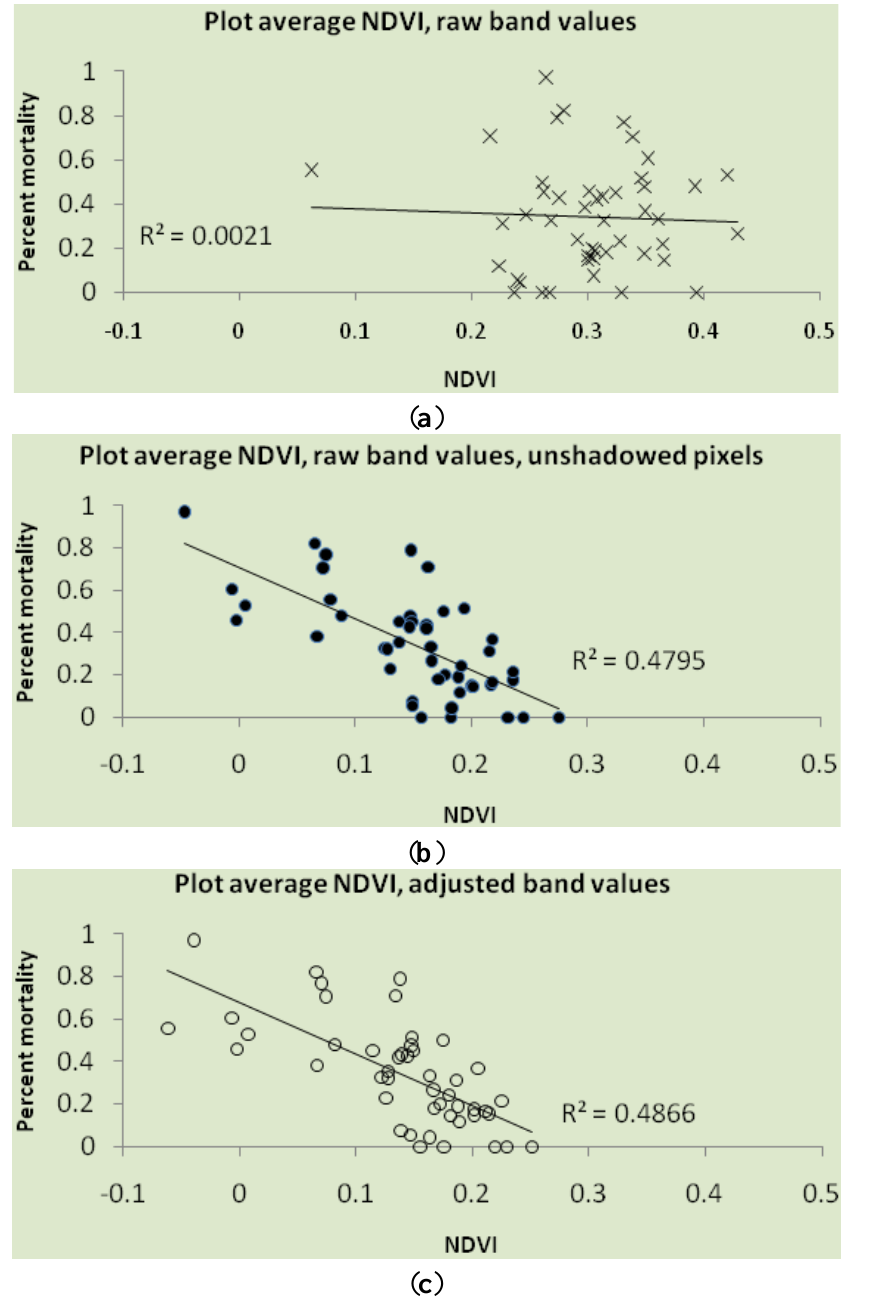
Figure 4. Linear fit for plot percent mortality on NDVI for ( a ) all pixels; ( b ) only unshadowed pixels; ( c ) all pixels, shadowed pixels have been